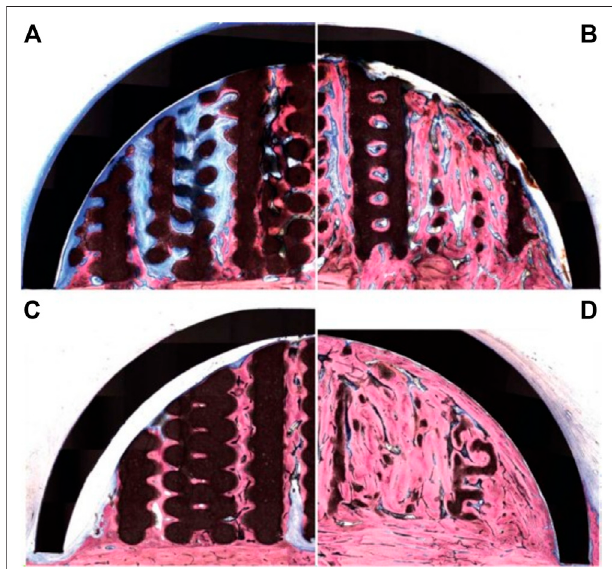
FIGURE 6 | 3D-printed bio-ceramic scaffold combined with Bone Morphogenetic Protein-2 for vertical bone formation. (A) : pristine 3D-printed bio-ceramic scaffold and (B) : BMP-2 loaded scaffold at 8 weeks post- implantation, (C) : pristine 3D-printed bio-ceramic scaffold and (D) : BMP-2 loaded scaffold at 16 weeks post-implantation demonstrating higher bone formation in the BMP-2 loaded scaffold along with advanced degradation of the bio-ceramic scaffold (in black) at the 16 weeks timepoint. Reproduced with permission from (Moussa et al.,